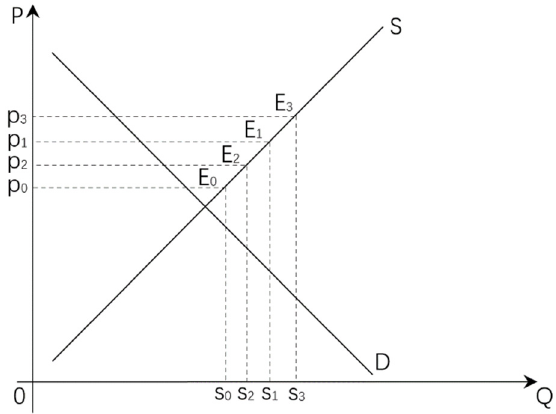
Figure 1. The effect of cotton target price on cotton production.